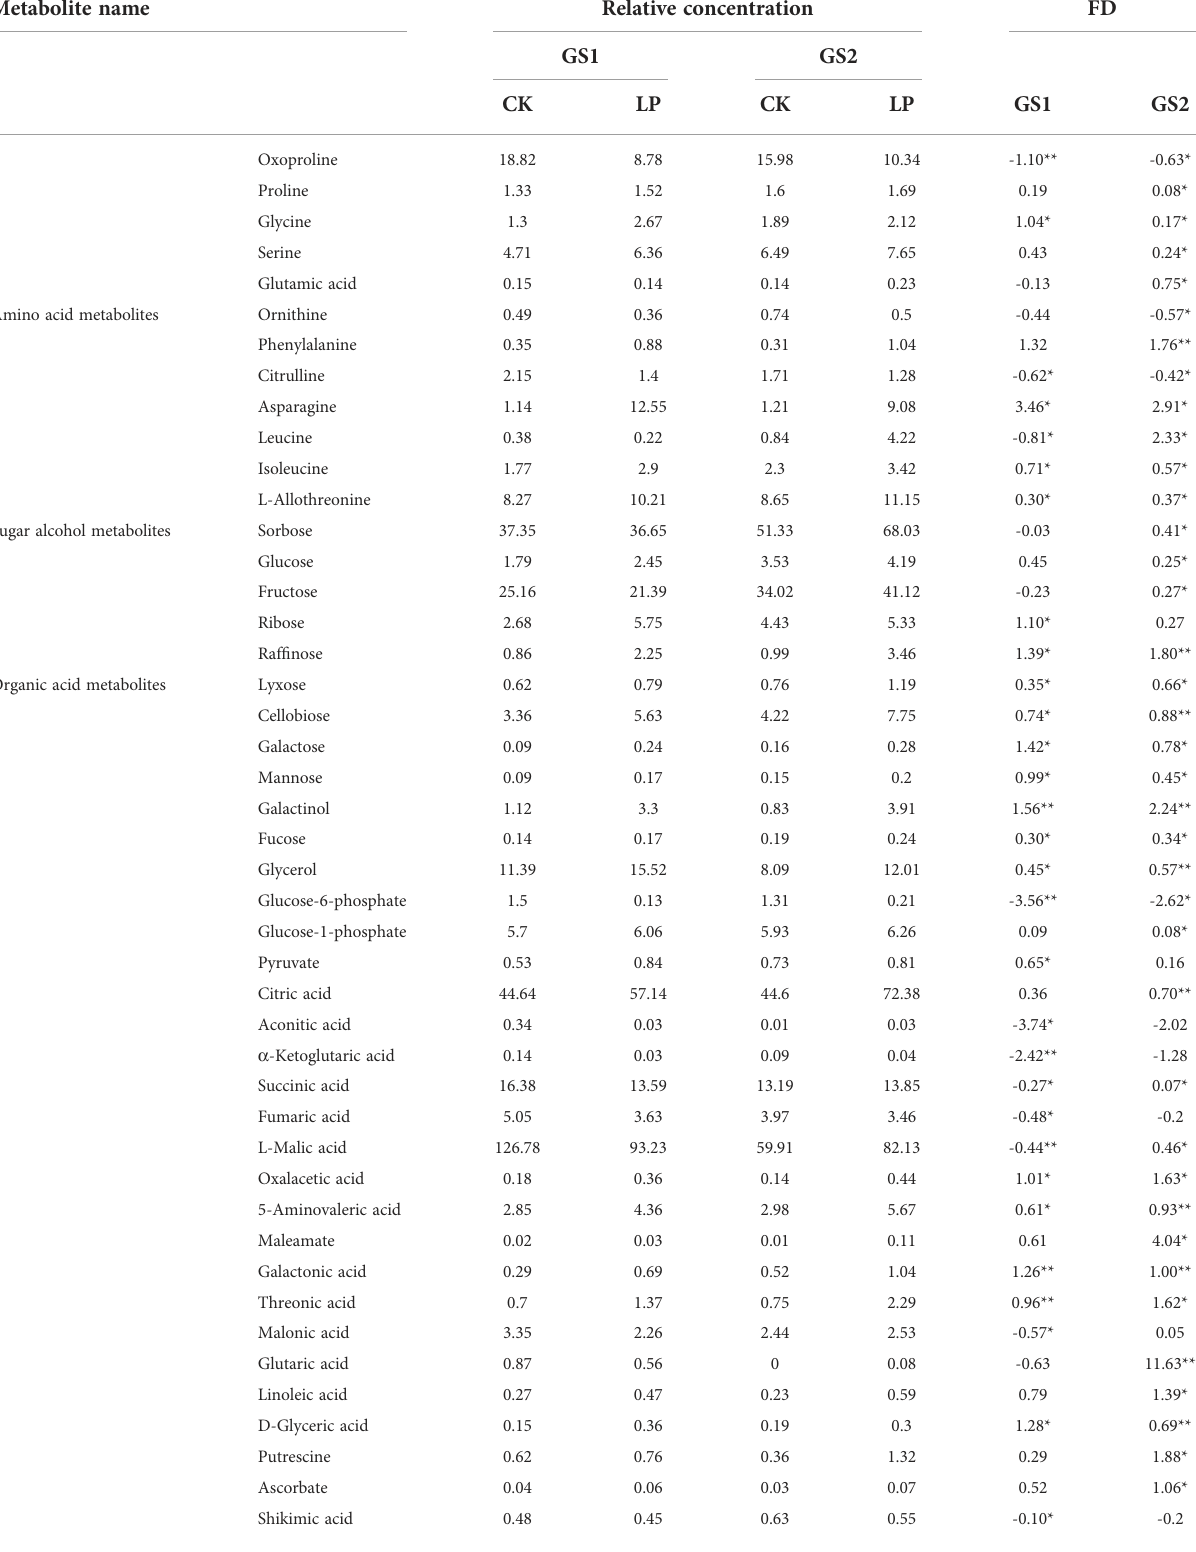
Metabolite name